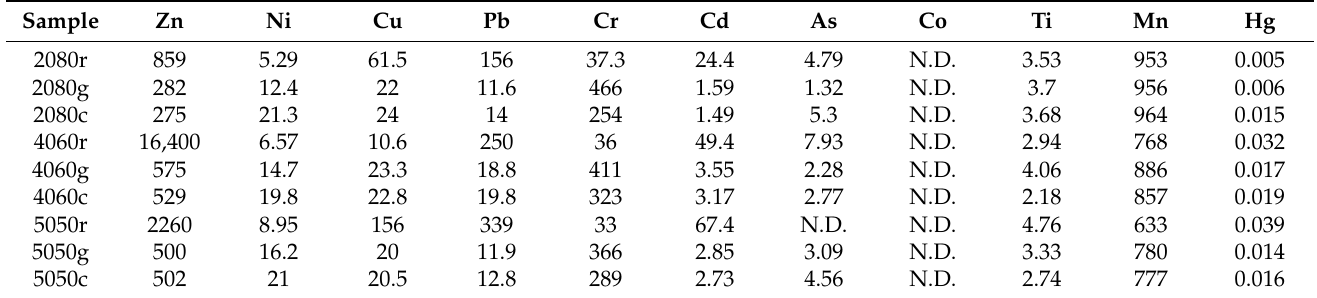
Table 7. The HMs contents of raw materials and samples determined by ICP-MS (ppm).